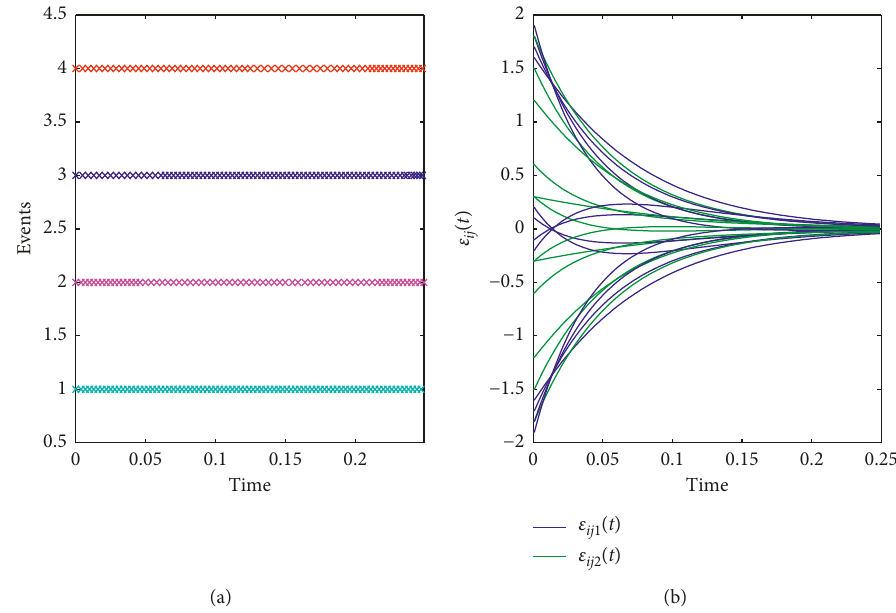
Figure 1: Time evolutions of the event-triggered controller and the synchronization errors in Example 1.